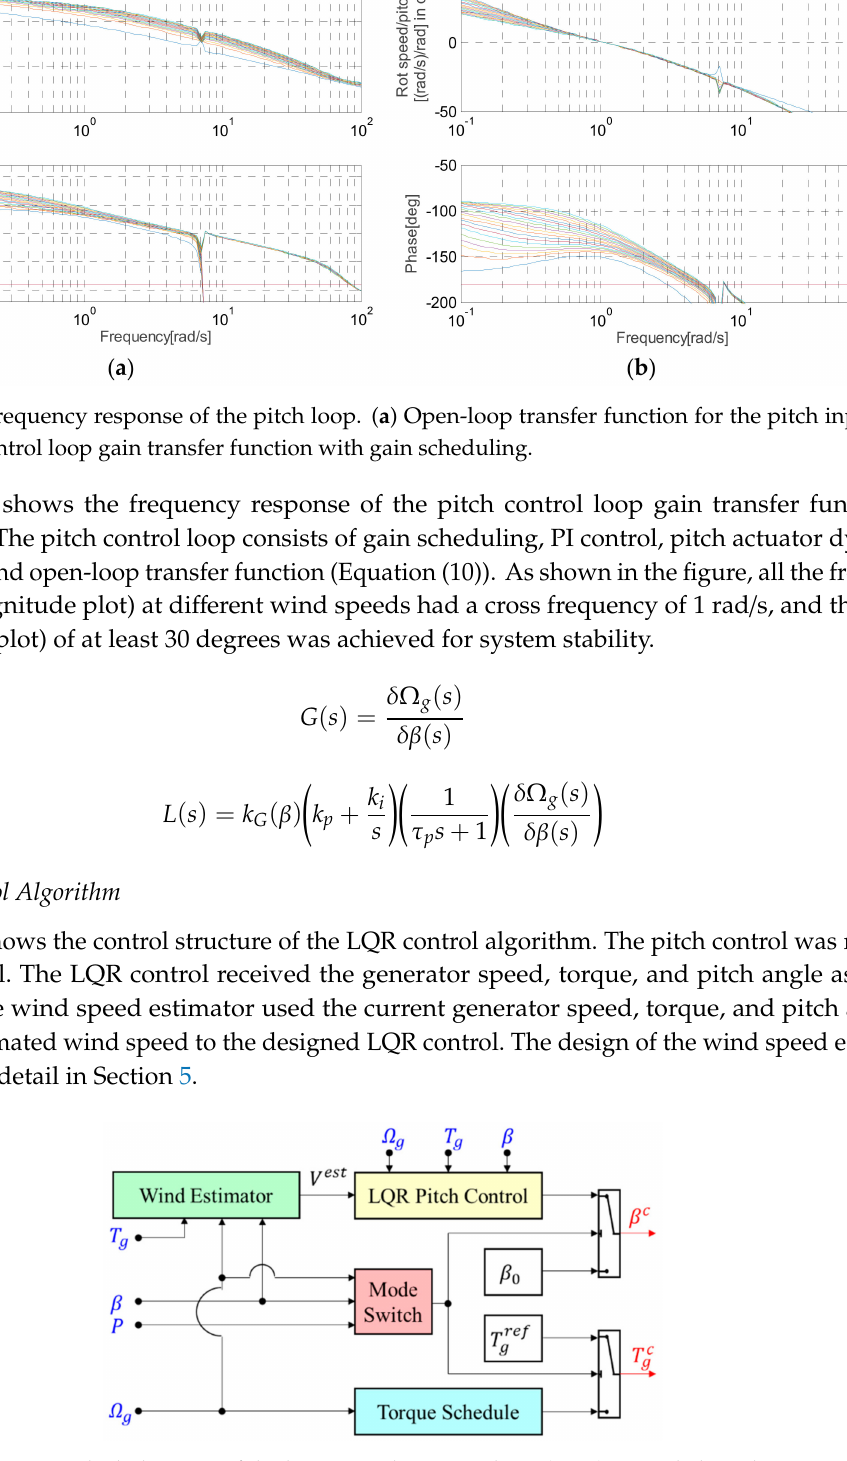
Figure 7. Block diagram of the linear quadratic regulator (LQR) control